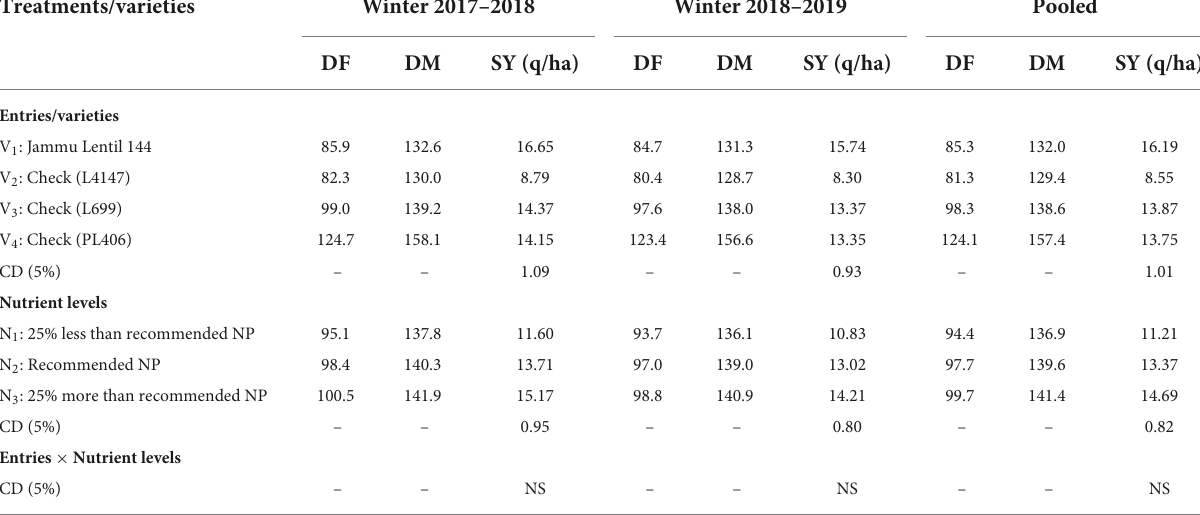
TABLE 8 Performance of selected derivative Jammu Lentil 144 at different nutrient levels under rainfed conditions of Jammu region.